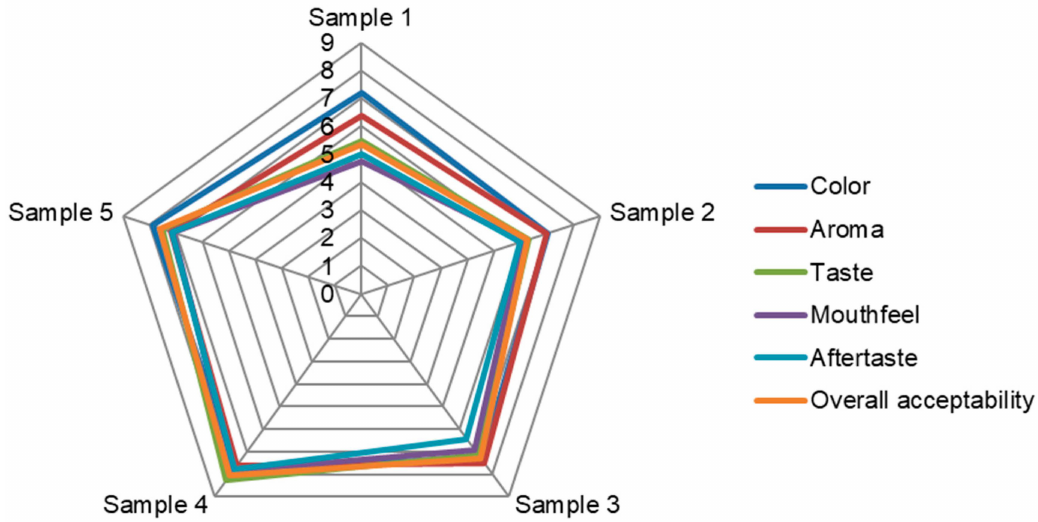
Figure 1. Overall liking scores (mean) of tomato-based pineapple beverage samples.